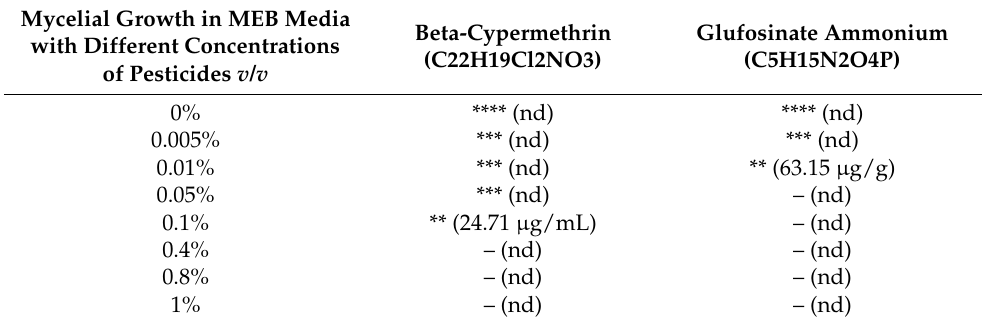
Table 4. Mycelial growth conditions of Agaricus subrufescens in MEB medium dissolved with different concentrations of Beta-cypermethrin and Glufosinate ammonium.